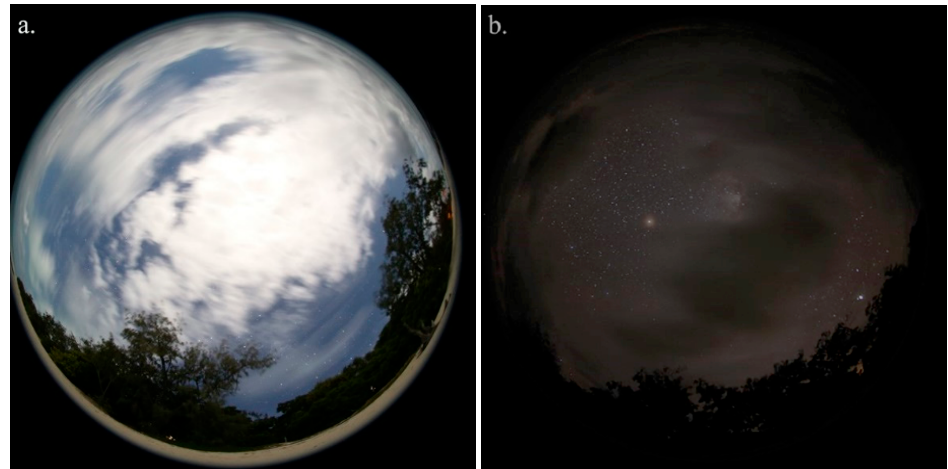
Figure 10. Zenith photographs taken on the night of ( a ) 21 June 2018 at sampling site 7 and ( b ) 14 June 2018 at sampling site 23 – Heron Island, Australia. These photographs demonstrate the two states in which clouds can affect brightness: ( a ) increase brightness under moonlit conditions i.e., clouds are brighter than the background sky and ( b ) decrease brightness under moonless conditions i.e., clouds are darker than the background sky.